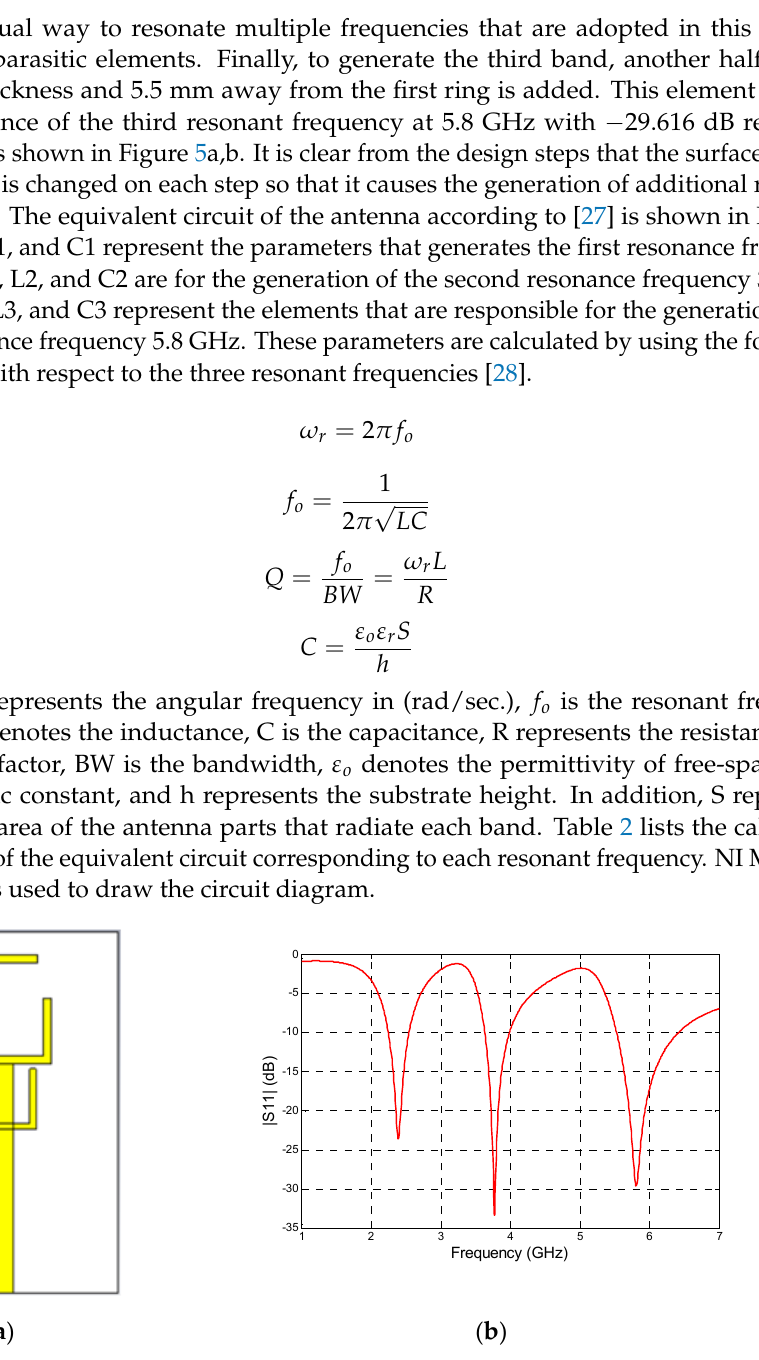
Figure 5. ( a ) The addition of the second half ring and ( b ) Its simulated reflection coefficient response.